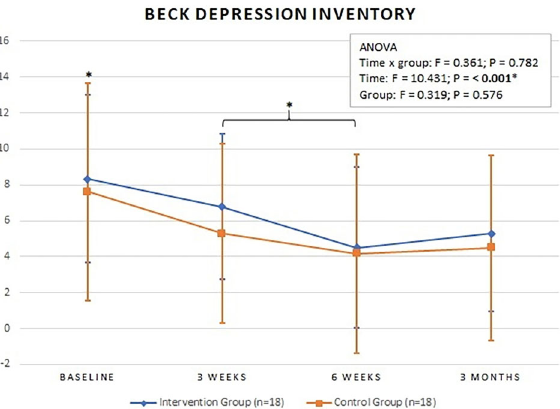
Figure 4. Mean values of the Beck Depression Inventory at baseline, 3 weeks, 6 weeks, and 3 months. Intervention Group: